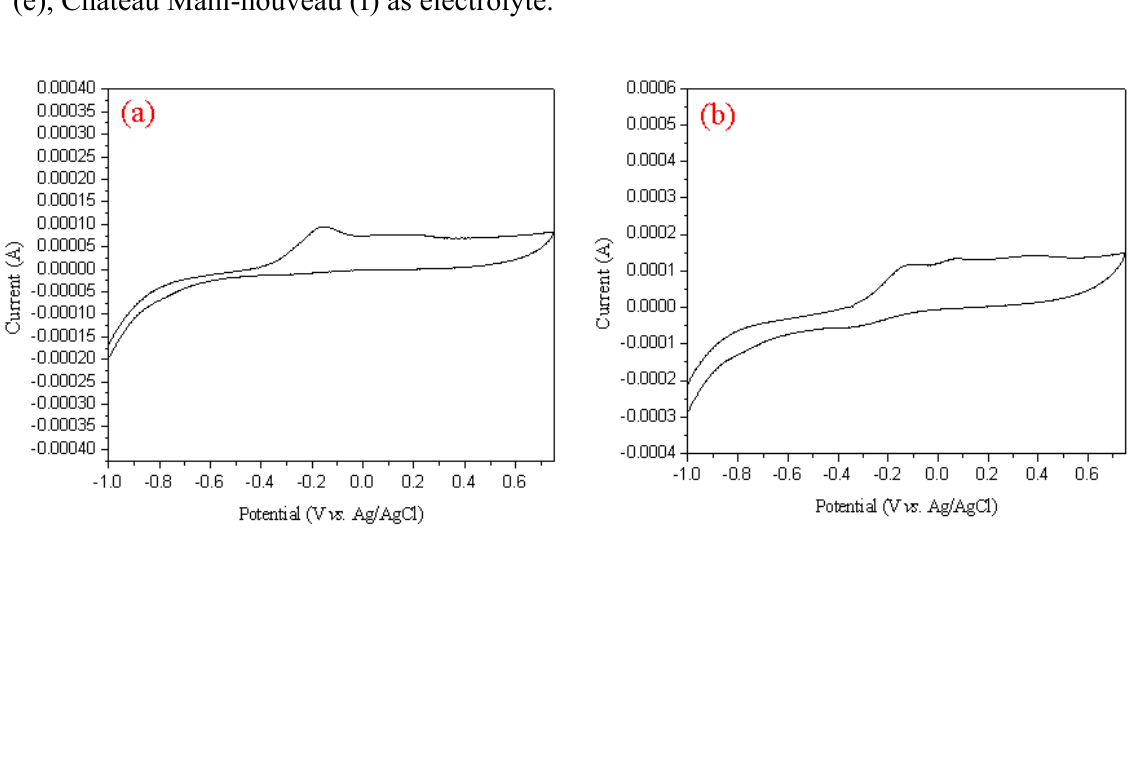
Figure 10. Cyclic voltammograms of MWNT ion liquid electrode based on tyrosinase in 2.0 mL phosphate buffer solution (pH = 7.0) containing 8 mL Chateau Mani-dry (a), Chateau Mani- sweet (b), Chateau Mani-nouveau (c) and in 2.0 mL Chateau Mani-dry (d), Chateau Mani-sweet (e), Chateau Mani-nouveau (f) as